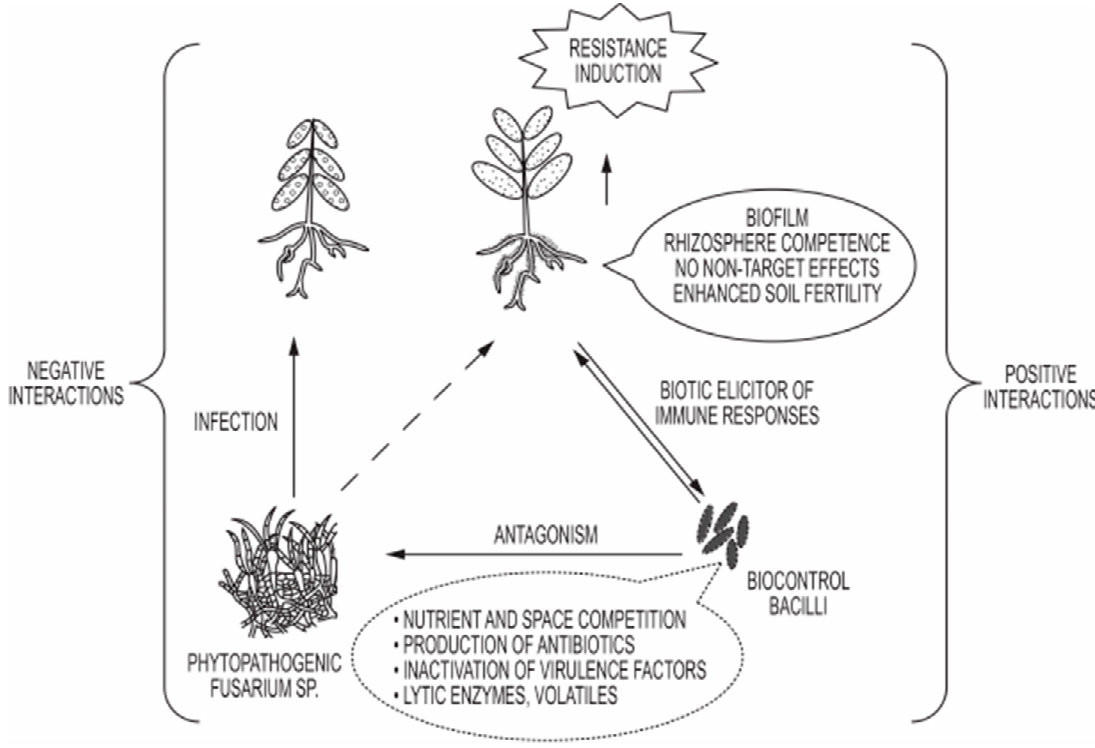
Figure 3. Schematic diagram illustrating the dynamic multifactorial interaction between Bacillus and Fusarium spp., and their relative impact on plant health.